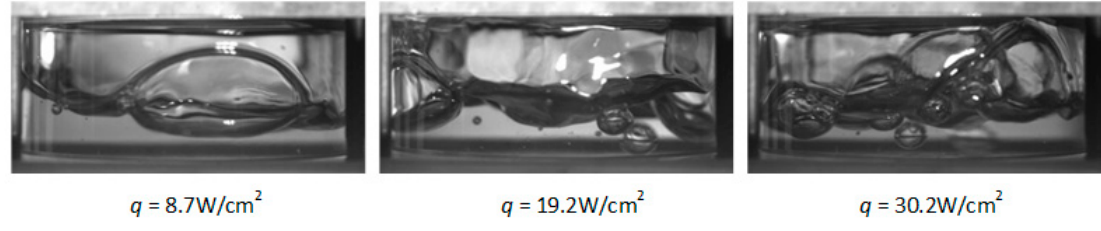
Figure 8. Effect of heat flux on two-phase flow behavior (working medium: water).